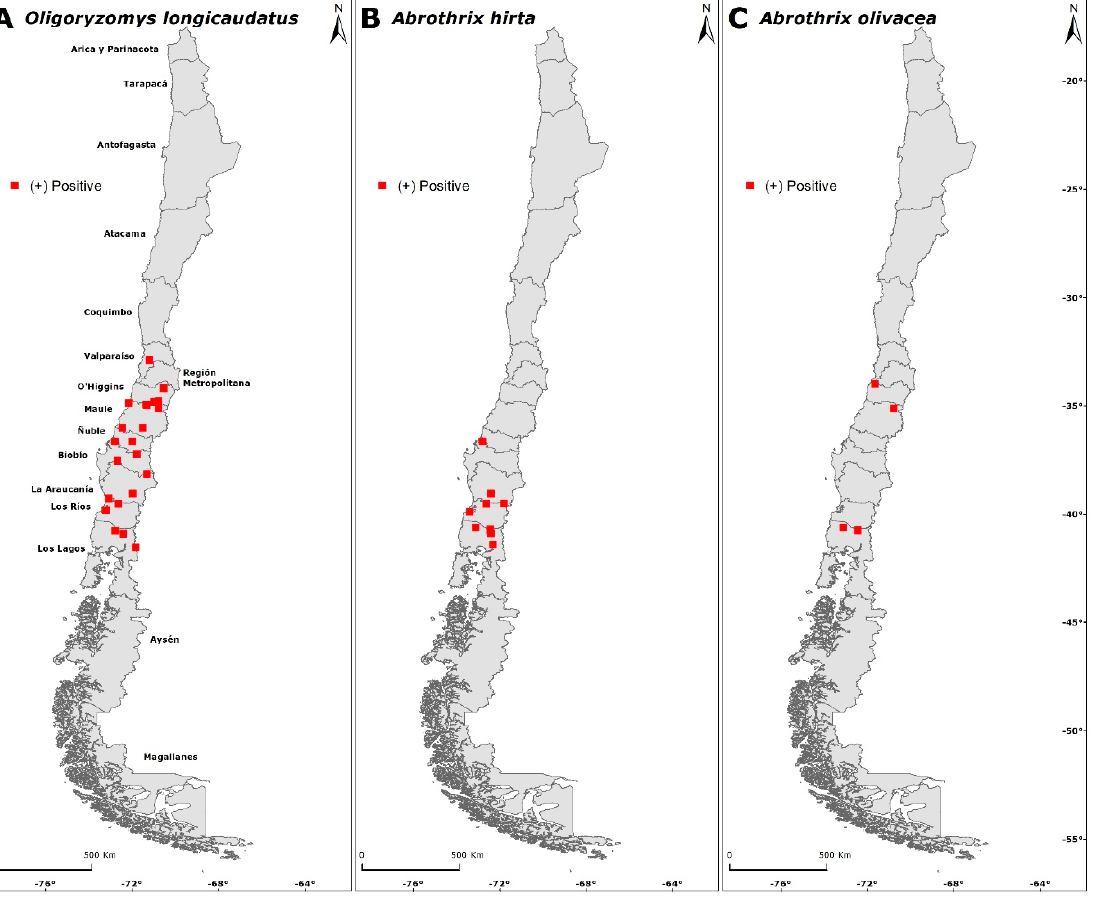
Figure 2. Distribution of rodents with anti-ANDV antibodies in areas associated with human hantavirus cases for O. longicaudatus , A. hirta and A. olivacea during the nineteen-year study in Chile. Among sites, the highest relative seropositivity for O. longicaudatus was reported in Las Peñas 2002, San Fernando, O’Higgins region and Los Queñes, Romeral, Maule region (3.6), and the lowest in Paso El Le ó n, Cocham ó , Los Lagos region and Colico, Cunco, Araucan í a region (0.08). A. hirta showed the highest relative seropositivity in Caleta Rollizo, Cocham ó , Los Lagos region (4.02) and the lowest in Playa San Juli á n, Corral, Los R í os region (0.14). A. olivacea showed the highest relative seropositivity in Los Queñes, Romeral, Maule region (3.6) and Uc ú quer, Litueche, O’Higgins region (0.32). Of the 631 O. longicaudatus captured, 127 had wounds, of which 26 (20.5%) were seropositive to ANDV, including 23 adult males and three adult females. Of the 101 seronegatives with wounds, 90 were adults and 11 juveniles; 55 were males and 46 females. Of the 234 A. hirta captured, 67